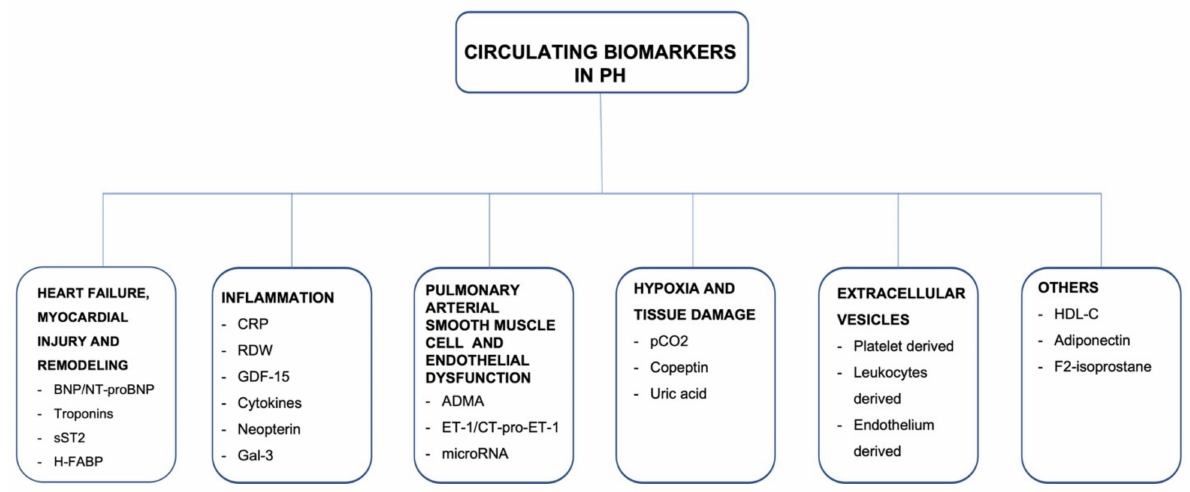
Figure 1. A summary of circulating biomarkers in precapillary pulmonary